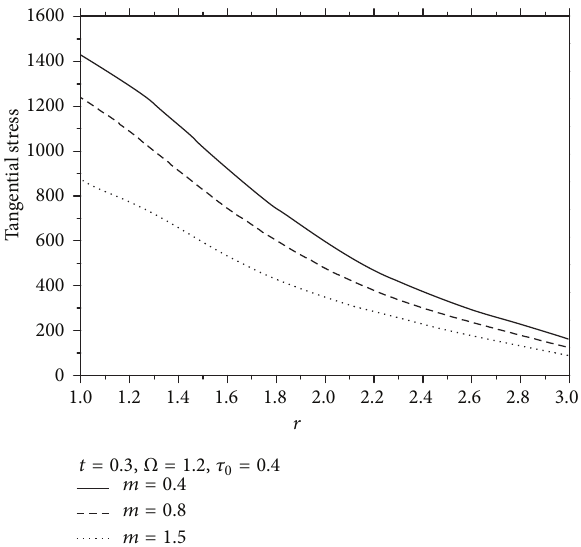
Figure 7: Variation of displacement 𝑢 with radius 𝑟 (thermoelastic nonhomogeneity medium).